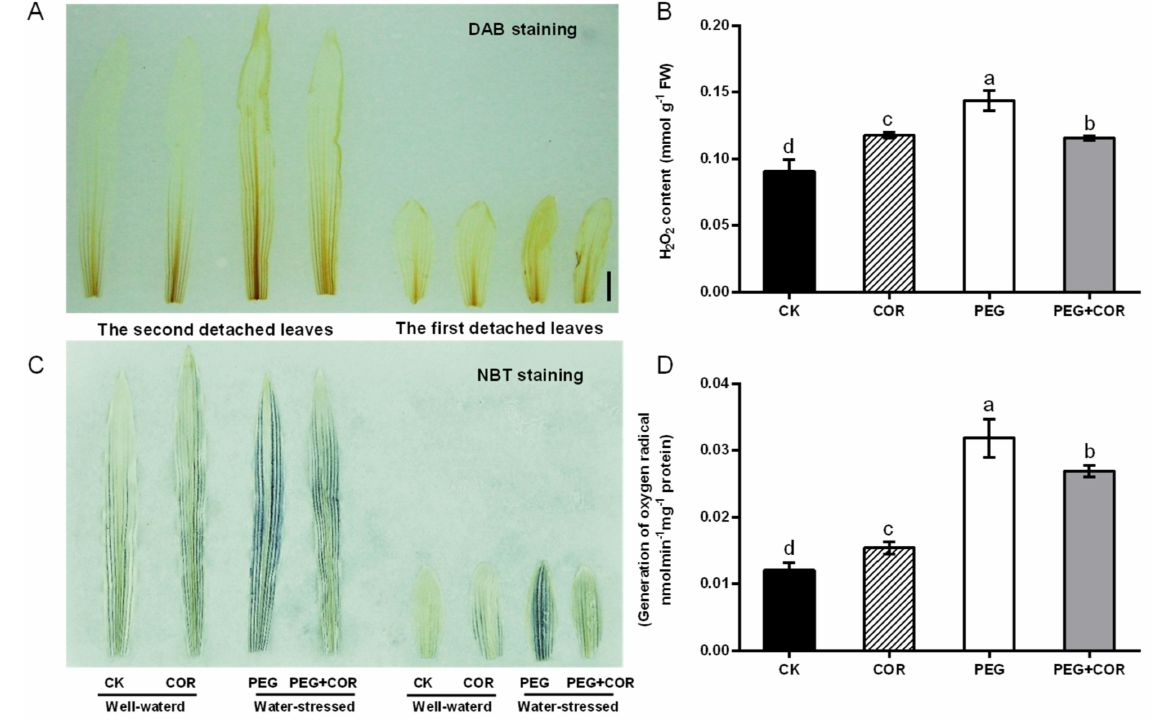
Figure 2. H 2 O 2 and O 2 − · accumulation in leaves of maize plants after treatments with COR in well-watered and drought plants. ( A ) Histochemical detection of H 2 O 2 and ( B ) O 2 − · with nitroblue tetrazolium (NBT) in maize leaves. The second leaves were homogenized, and ( C ) H 2 O 2 content and ( D ) O 2 − · were assayed by spectrophotometry. CK and COR indicated the well-watered plants and well-watered plants treated with COR, respectively. PEG and PEG+COR indicate the water- stressed plants and water-stressed plants in presence of COR, respectively. Values are the mean ± SD ( n =3), and different letters indicate significant differences ( p < 0.05) among the treatments. Bars = 2 cm.